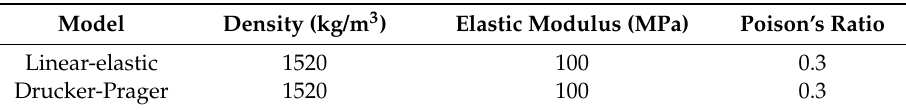
Table 2. Material properties of the soil models.